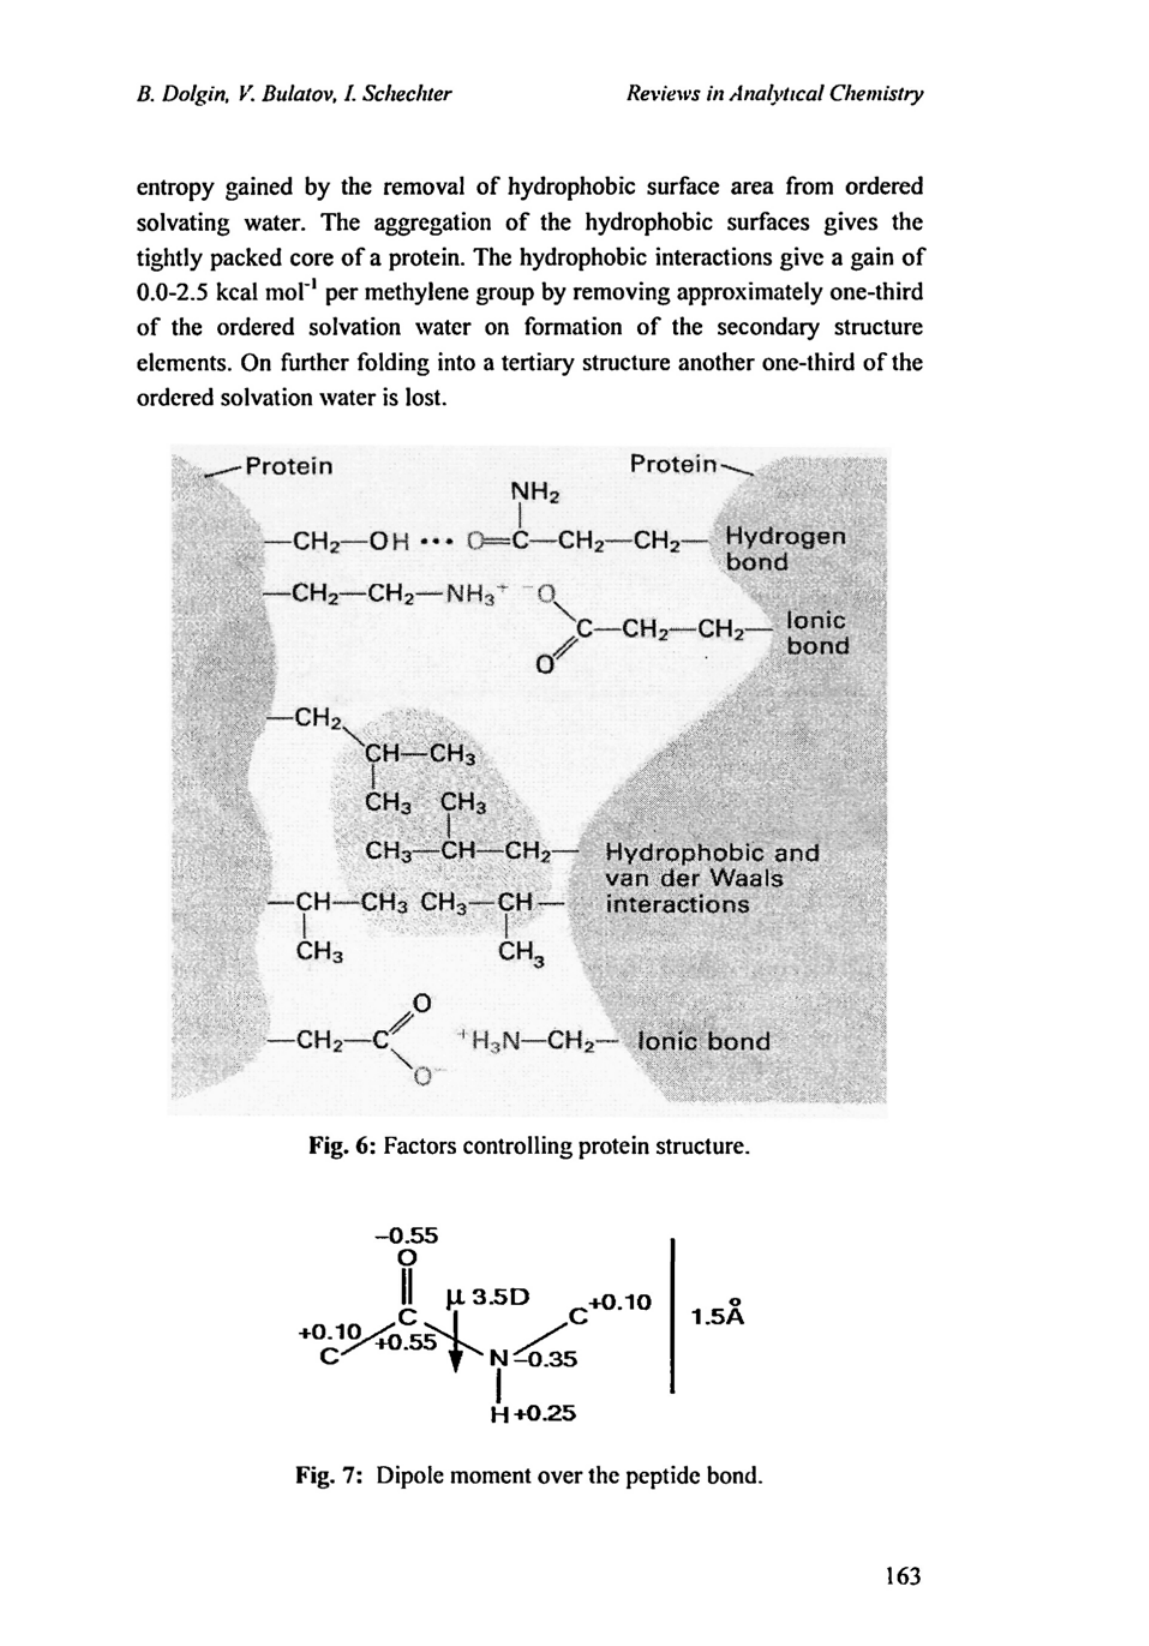
Fig. 7: Dipole moment over the peptide